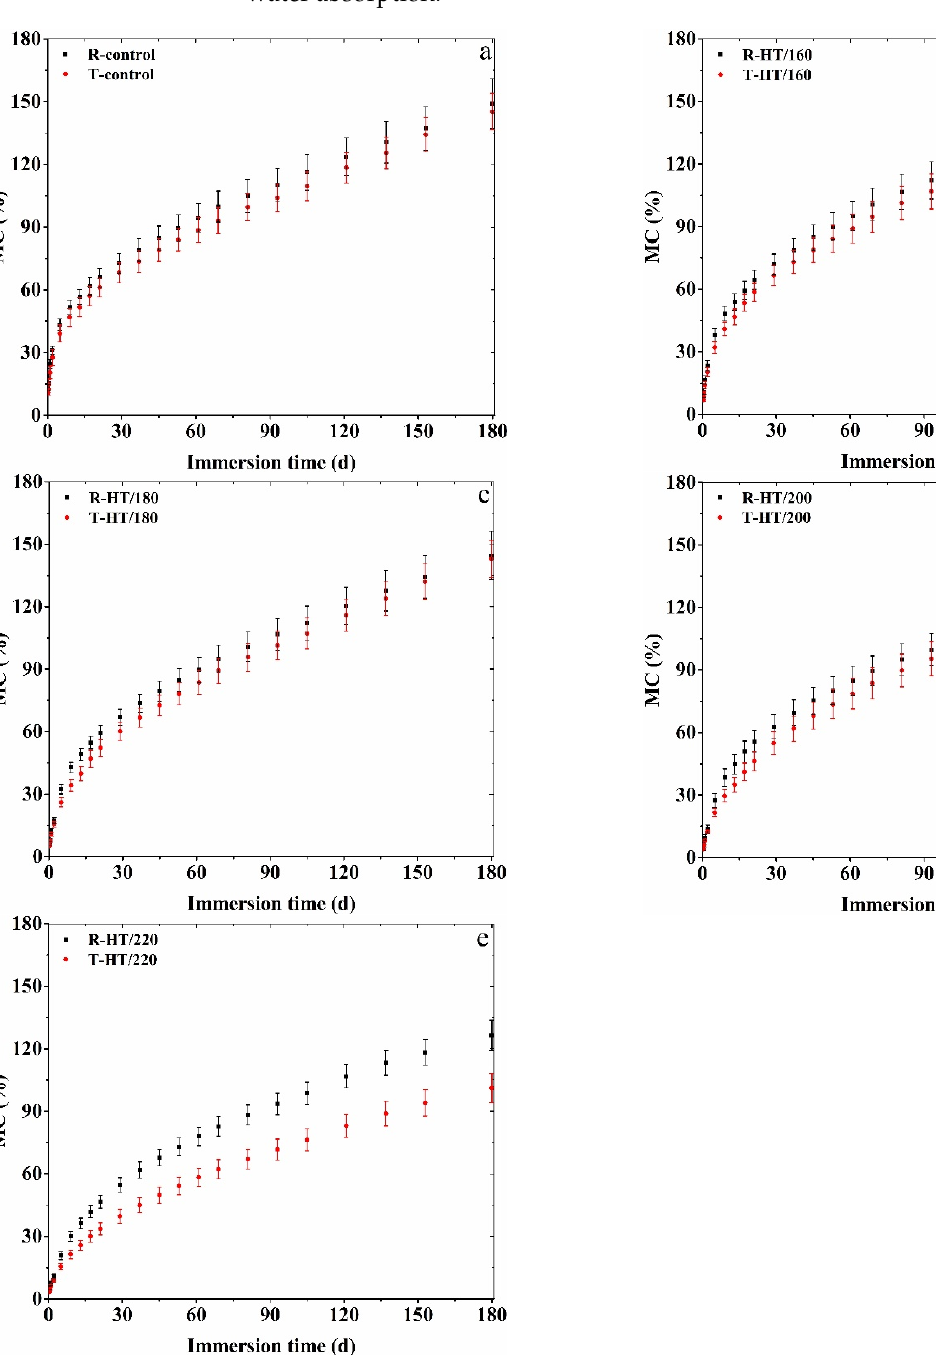
Figure 2. The average MCs’ (with standard deviations) comparison of water absorption in the radial and T directions for samples under same heat-treated temperature and the references.